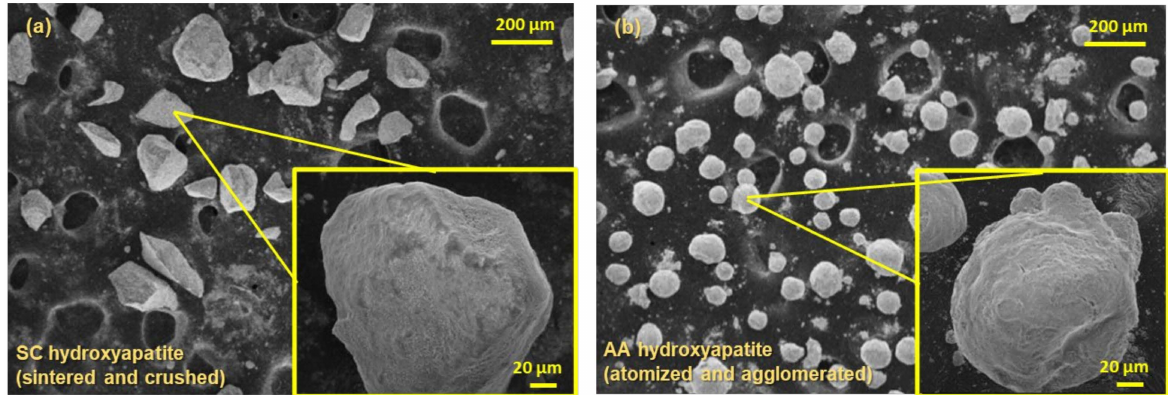
Figure 4. Commercial powders SEM analysis: ( a ) SC powders and ( b ) AA powders.